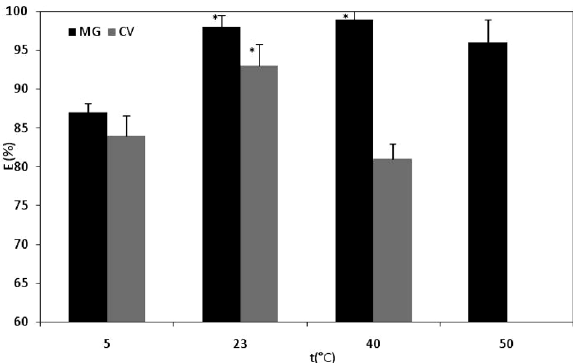
Fig. 3. The effect of temperature on the dye removal efficiency of the Lemna minor in the phytoremediation process ; T = 40 °C and T = 50 °C only in the case of MG, in condi- 23 °C, T 3 4 tions of m = 3g, C = 100 mg/L, V = 250 mL; values mean ± plants i standard deviations (n = 3); *significant difference at P <